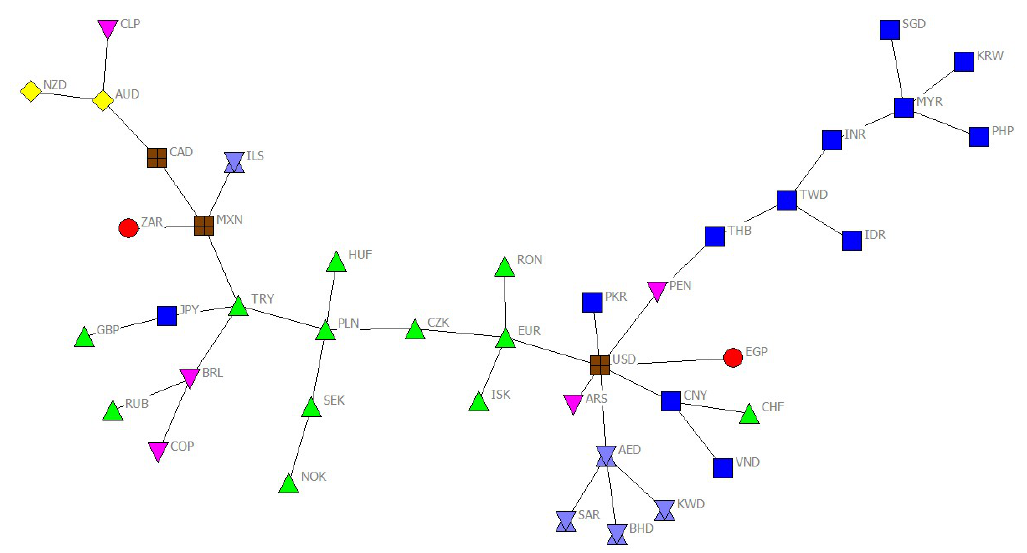
Figure 3. FX network during 22 February 2010–24 September 2010, as a representative of European debt